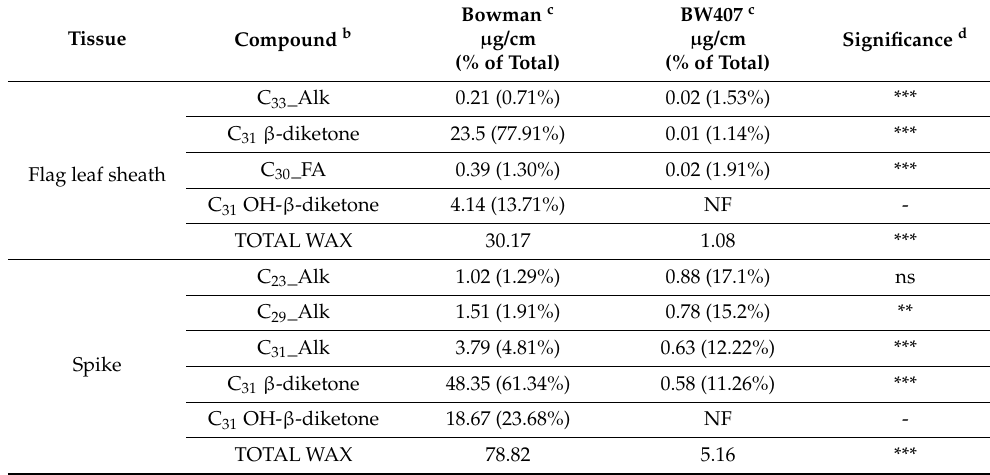
Table 2. Relative abundance of major wax components on flag leaf sheaths and spikes a